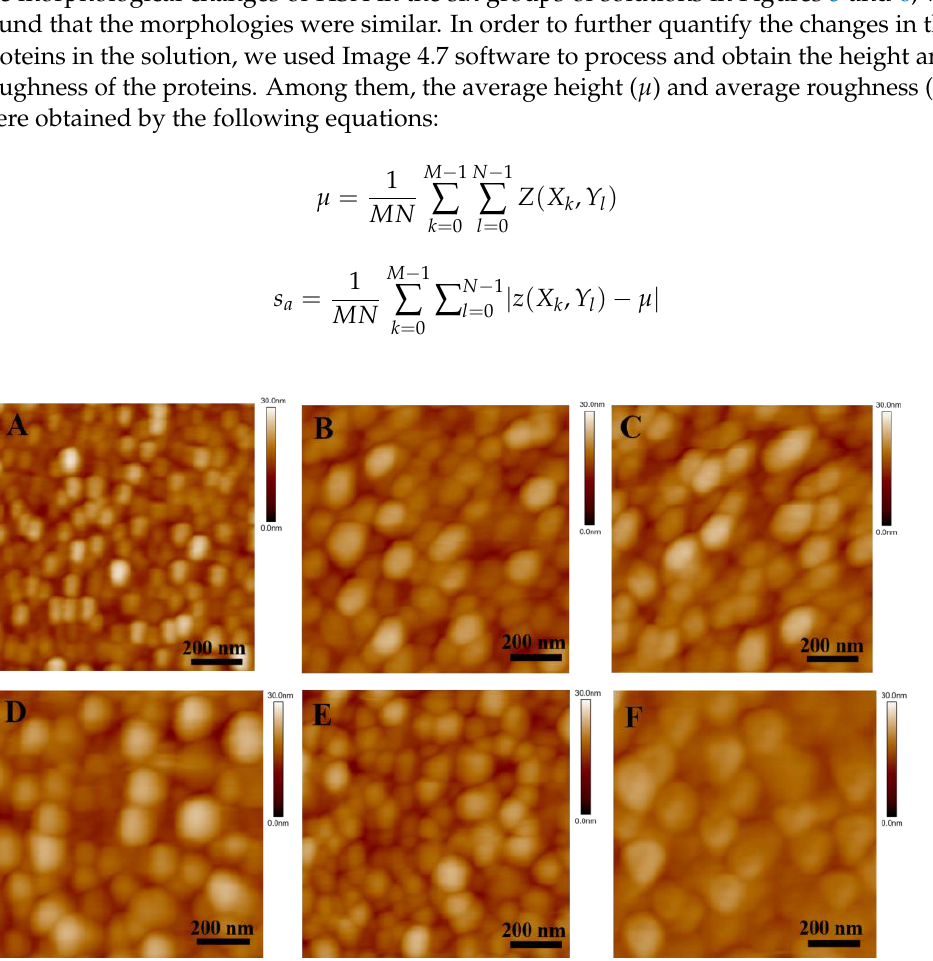
Figure 5. Morphology of HSA in different solutions characterized by AFM. ( A ) The control, ( B ) imatinib, ( C ) dasatinib, ( D ) nilotinib, ( E ) bosutinib, ( F ) ponatinib. Image size is 1 × 1 µ m 2 ; the scale bar is 200 nm; height scale is 30 nm from dark to